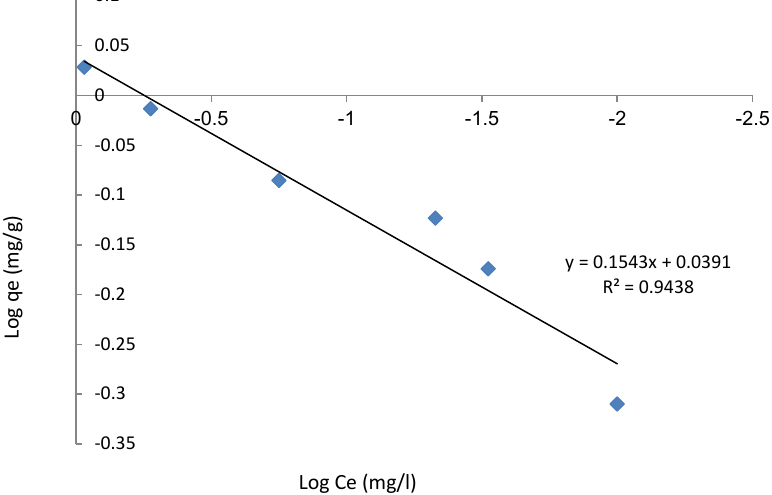
Fig. 6. Linear curve of Freundlich adsorption isotherm for As adsorption using the prepared